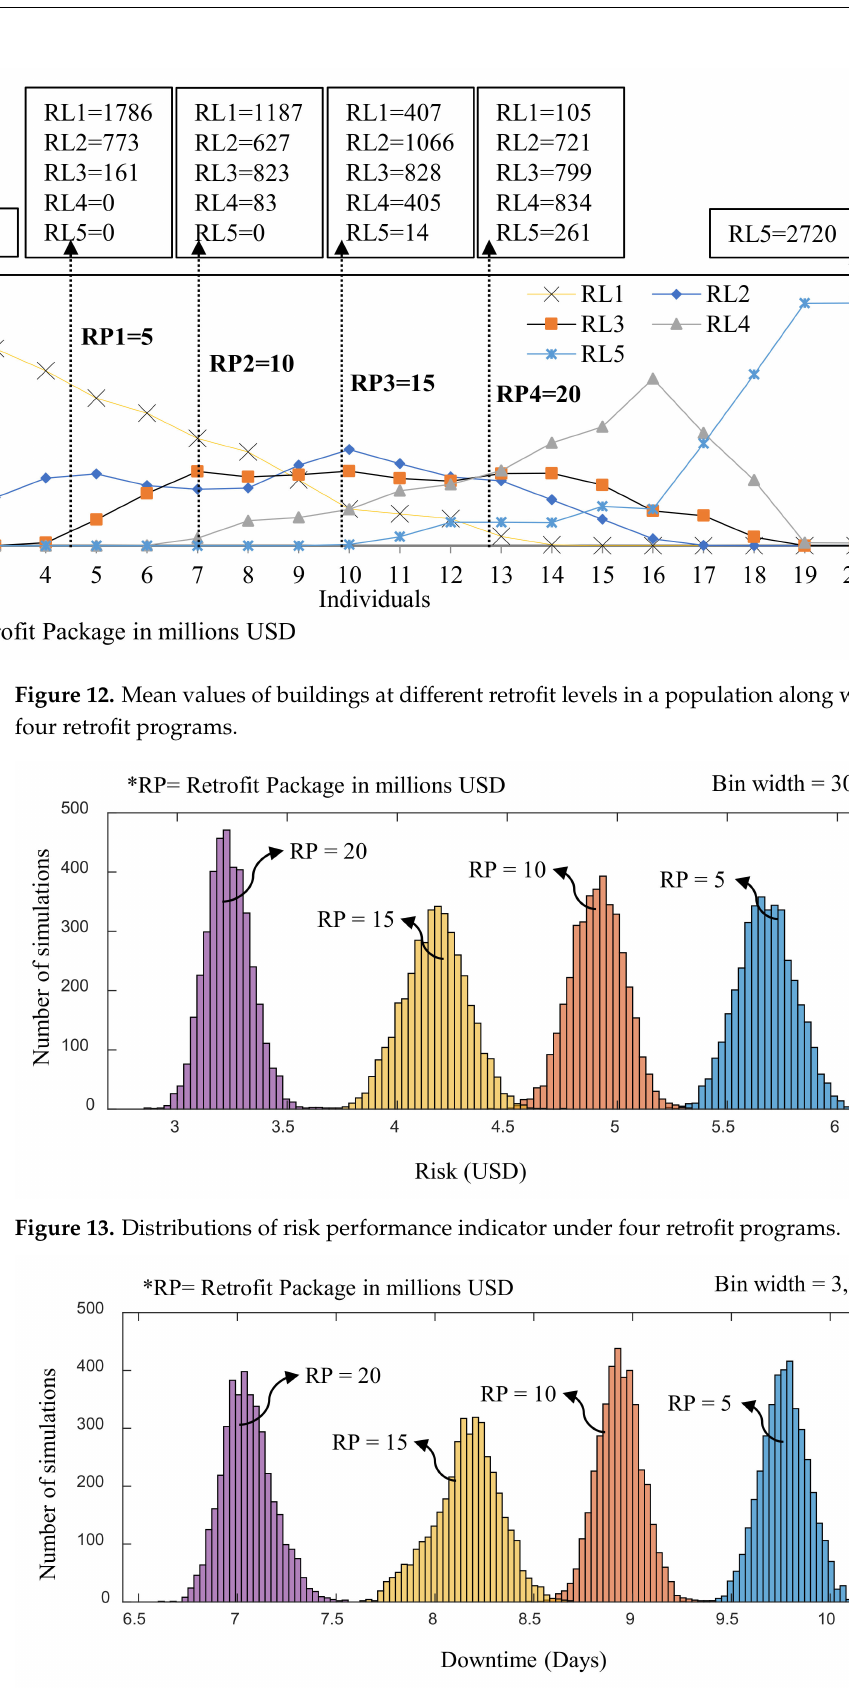
Figure 14. Distributions of downtime performance indicator under four retrofit